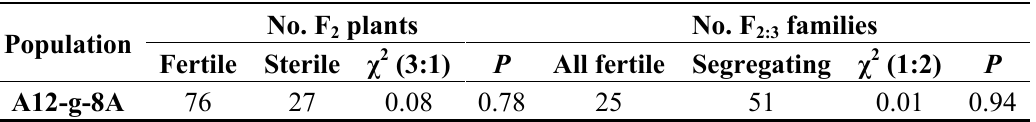
Table 1. F and F segregation patterns, Chi-square and P-values for populations of 2 2:3 Manchu ( Ms5Ms5 ) × T277H ( Ms5ms5